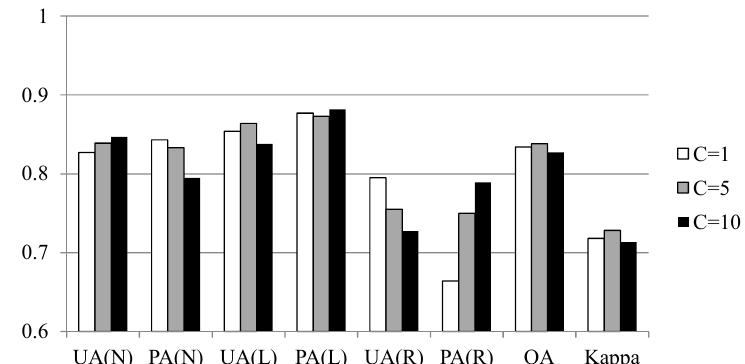
Figure 9. Quantitative evaluations of Model-1 using different cost settings to balance the run-out’s omission and commission errors. C—cost weight in a cost matrix, OA—overall accuracy, Kappa—kappa coefficient.